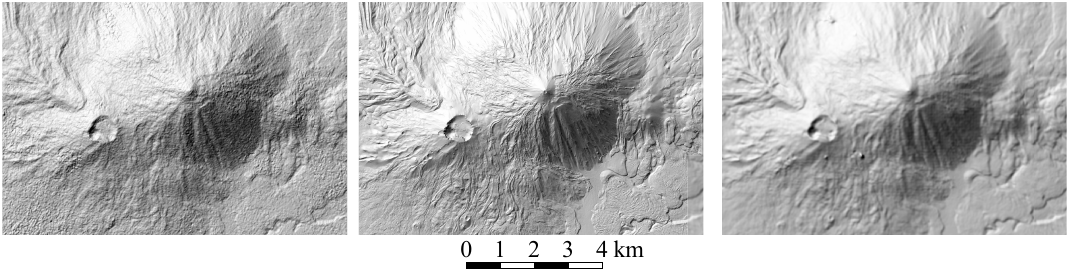
Figure 10. HillShade of: PlanetScope DEM ( Left ); LiDAR DEM ( Middle ); and ALOS DEM ( Right